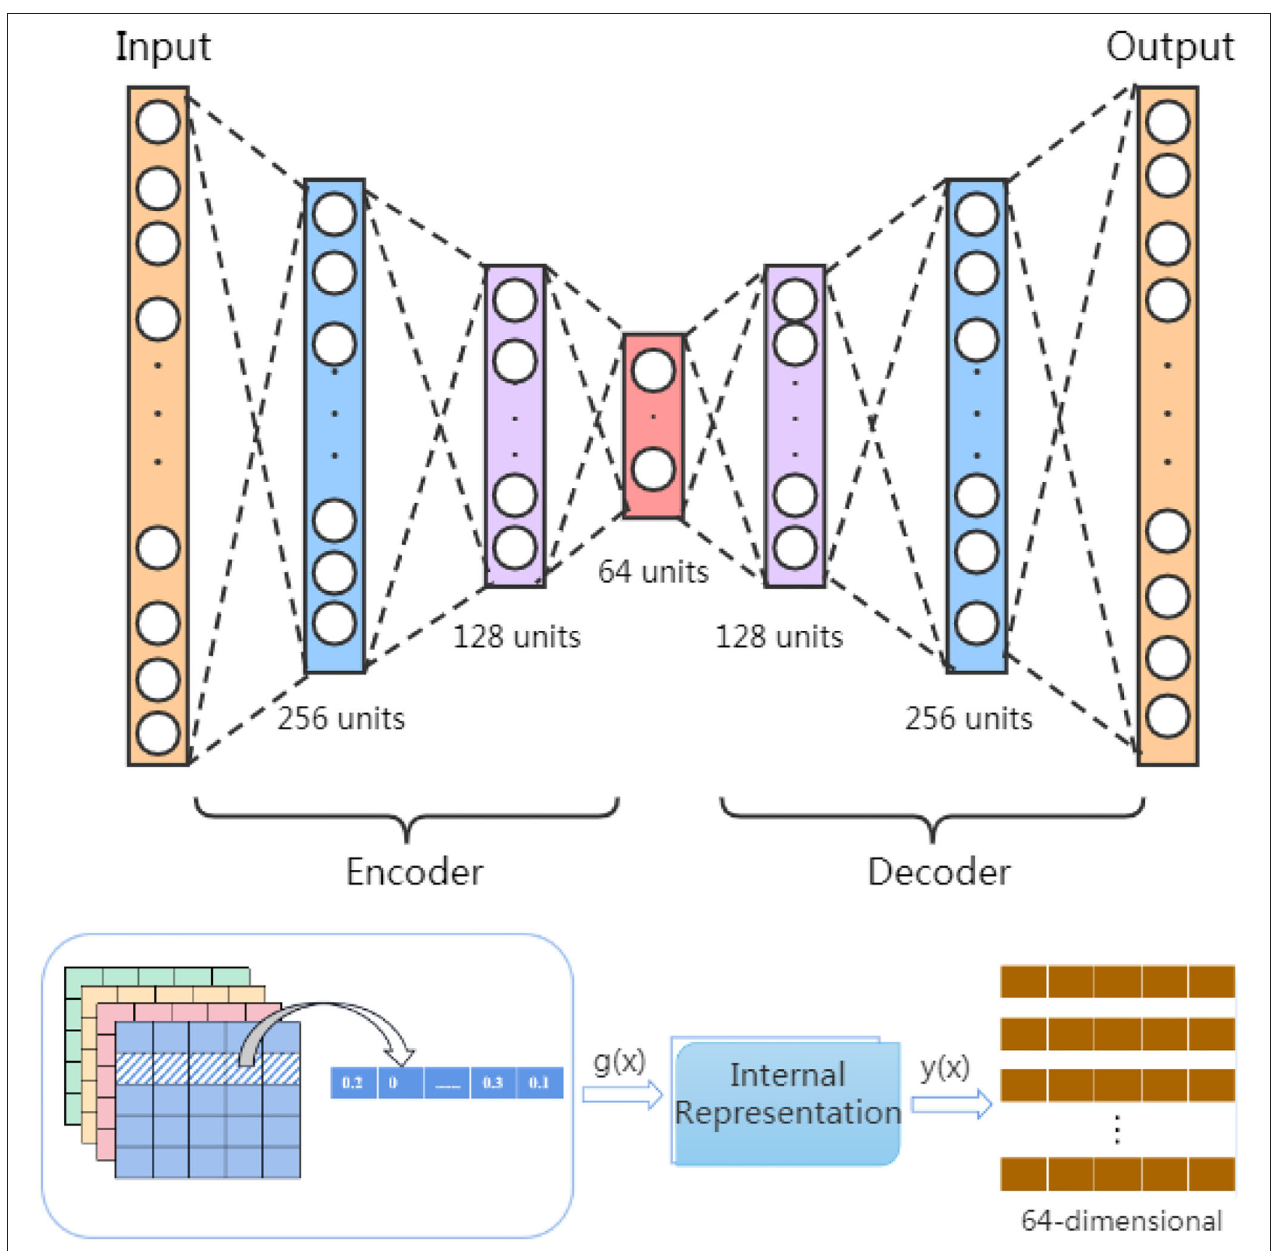
FIGURE 2 | Extract high-order features based on